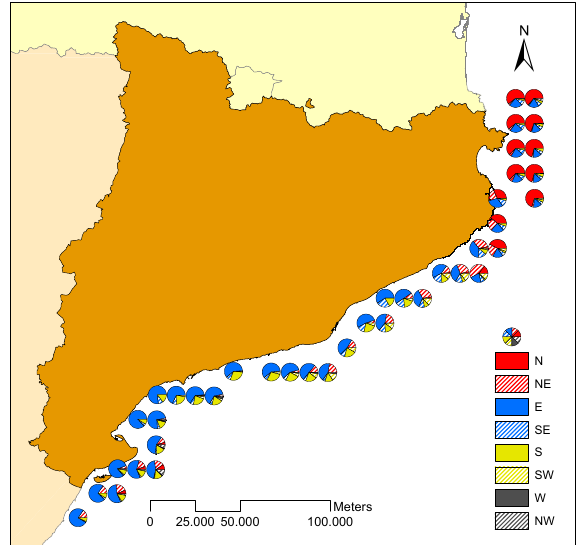
Fig. 4. Mean frequency for each direction for the data period 1958– 2001 (sector areas proportional to the